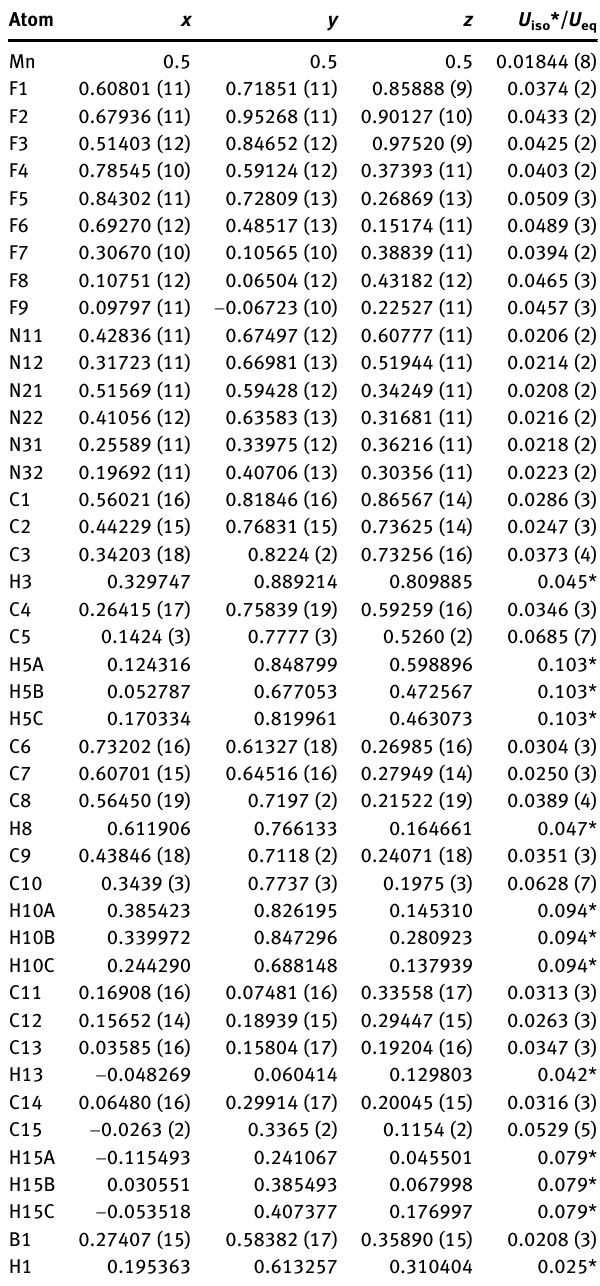
Table  : Fractional atomic coordinates and isotropic or equivalent isotropic displacement parameters (Å 